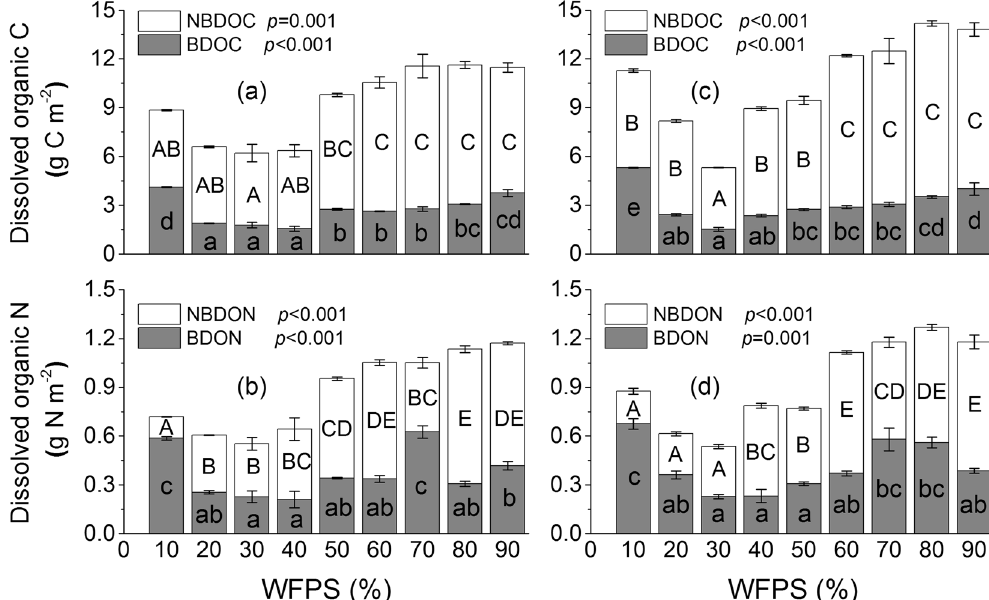
Figure 1. Effects of soil moisture on BDOM and NBDOM concentrations of soil water extracts. ( a ) and ( b ) represent for WBF soil; ( c ) and ( d ) represent for BKPF soil. Different lowercase and capital letters indicate significant differences of BDOM and NBDOM concentrations between different soil moisture levels at the p < 0.05 level, respectively. Significant levels for the effect of soil moisture on BDOM and NBDOM pools are shown inside each sub-plot. Error bars reflect the standard error of BDOM and NBDOM concentrations between replicates, respectively ( n = 3 for all